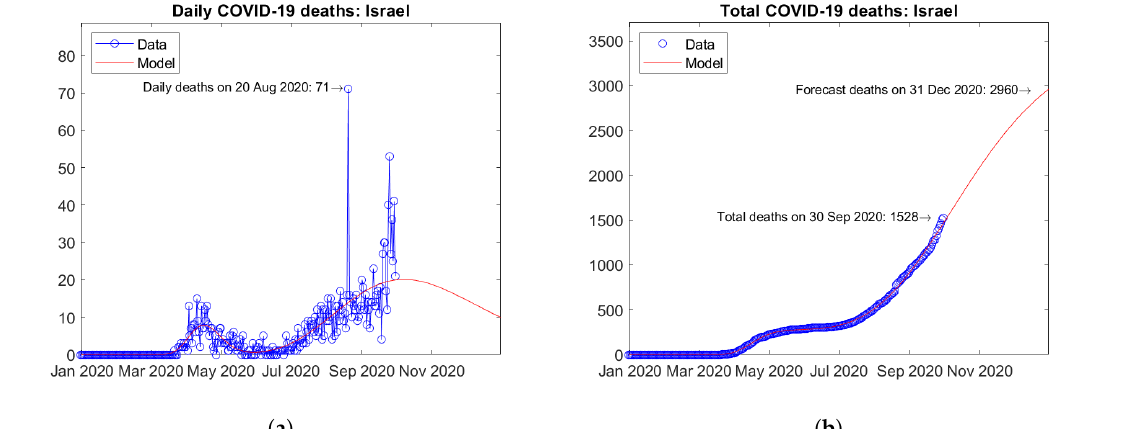
Figure 7. Actual and predicted trends in Israel: ( a ) daily deaths, ( b ) total deaths.